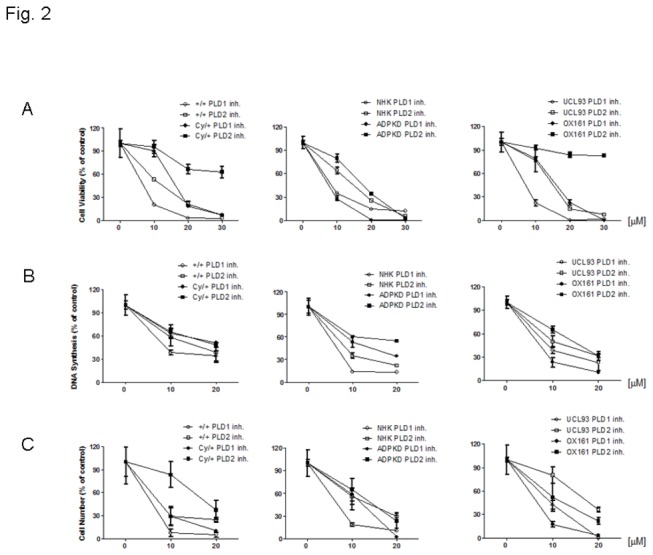
PLD inhibitors impair cell growth and block PLD activity in PKD cells.Effect of PLD1-/2-inhibitors on (A) the cell viability, (B) DNA synthesis ability and (C) cell proliferation were determined by MTS, BrdU and cell counting, respectively. All types of cells were exposed to various concentrations of either PLD1 or PLD2 inhibitor for 48 h. An experiment which is representative of three independent experiments is shown.